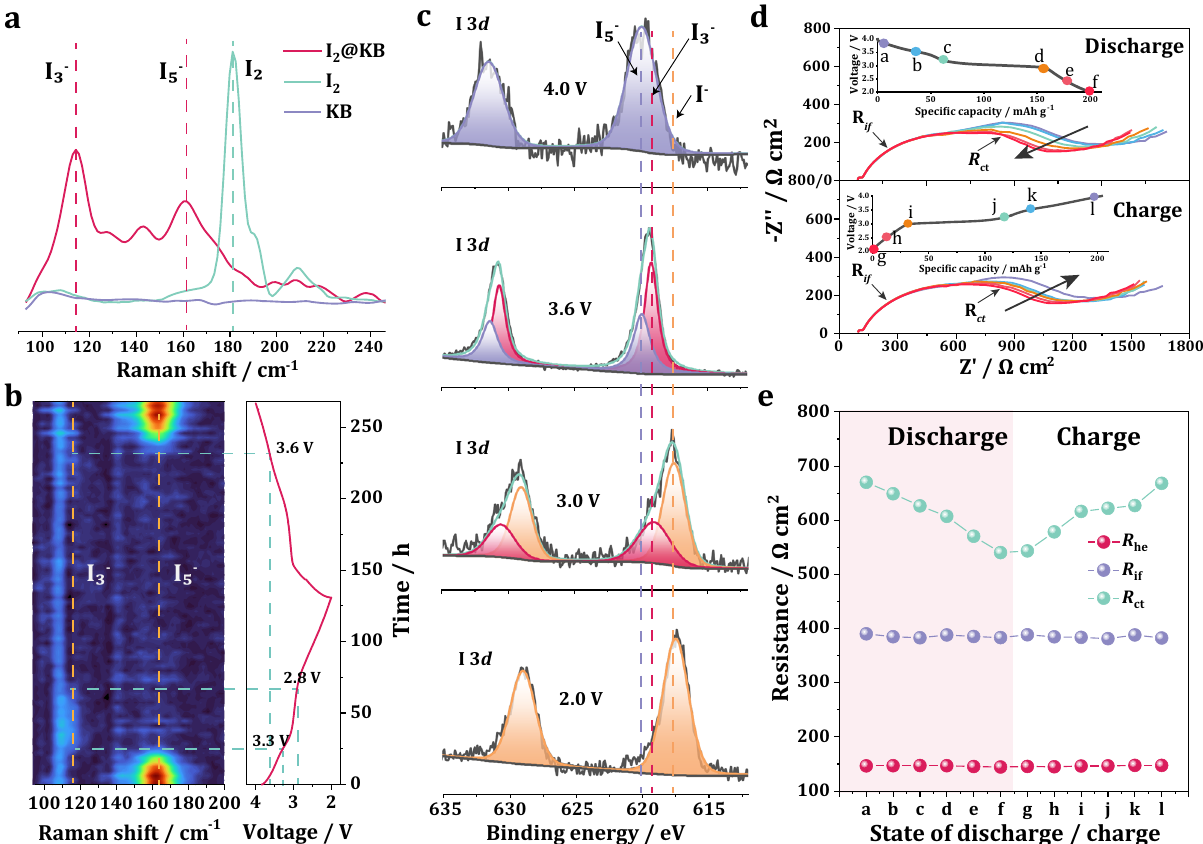
Fig. 3 Reaction mechanism study of all-solid-state LIB. a Ex situ Raman spectra of pure I 2 , KB and I 2 @KB cathode. b In situ Raman spectra of I 2 @KB cathode at different discharge and charge states for the second cycle. c I 3 d XPS spectra of the I 2 @KB cathode at different state of discharge. d EIS curves of the battery during different charge and discharge state. e The evolution of electrolyte resistance R he , interfacial resistance R if and charge transfer resistance R ct at different SOD/SOC shown in ( d